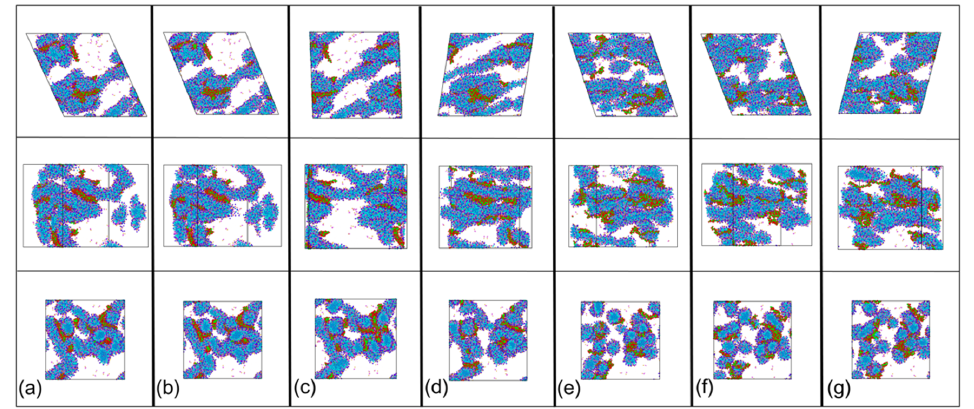
Figure 5. Snapshot of the PAM based solution when the shear rate is 1.08 × 10 9 s − 1 . ( a ) time: 0.5 ns; ( b ) time: 0.55 ns; ( c ) time: 0.89 ns; ( d ) time: 1.99 ns; ( e ) time: 8 ns; ( f ) time: 9.8 ns; ( g ) time: 10.4 ns. Top view: first line, front view: second line, left view: third line. Color scheme: purple, hydrophilic part of CTAC; cyan and blue, hydrophobic tail of CTAC; magenta, aromatic ring of Sal − ; khaki, charge group of Sal − ; red, the acidammide group of PAM; green, carbon backbone of PAM. Na + (yellow), Cl − (dark green), water sites (reddish), and antifreeze water sites (grey) were